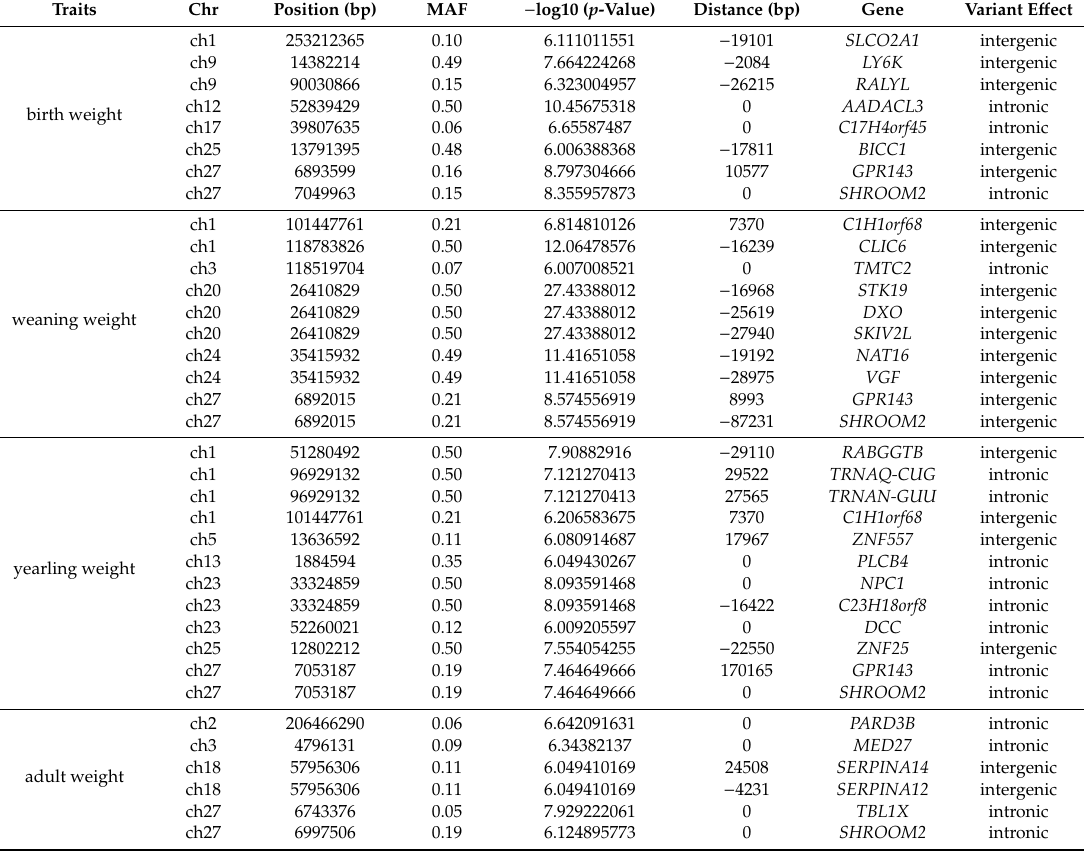
Figure 1. Manhattan plots of body weight traits for four fine-wool sheep breeds. The grey horizontal lines in the Manhattan plots indicate the suggestive significance (10 − 6 ) thresholds. ( A ) birth weight; ( B ) weaning weight; ( C ) yearling weight; ( D ) adult weight. Table 1. Genome-wide association studies (GWAS)-identified significant single-nucleotide polymorphisms (SNPs), associated traits, and nearest candidate genes. Traits Chr Position